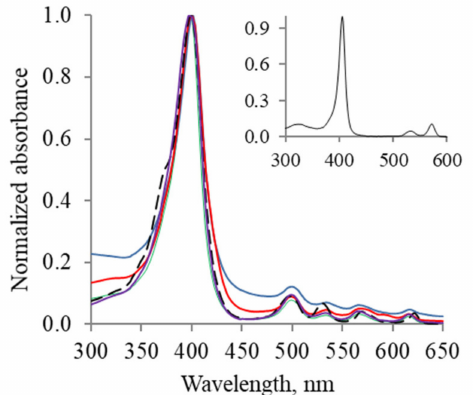
Figure 1. UV-Vis spectra of demetallized petroleum porphyrins obtained with methanesulfonic (blue), sulfuric at rt (red) and at 0 ◦ C (purple), and 1:4 mixture of sulfuric and trifluoroacetic acids (green). Dashed line is the absorbance of synthetic octaethyletioporphyrins of 97% purity. The inset is the UV-Vis spectrum of the initial petroleum vanadyl porphyrins. All spectra were registered in